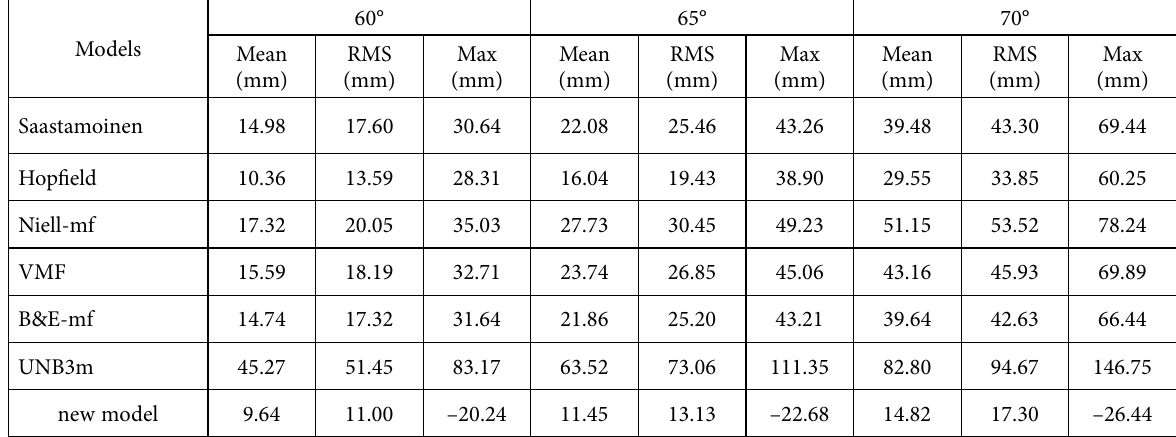
Table 4. Tropospheric delay difference (in mm) between different models and NIM